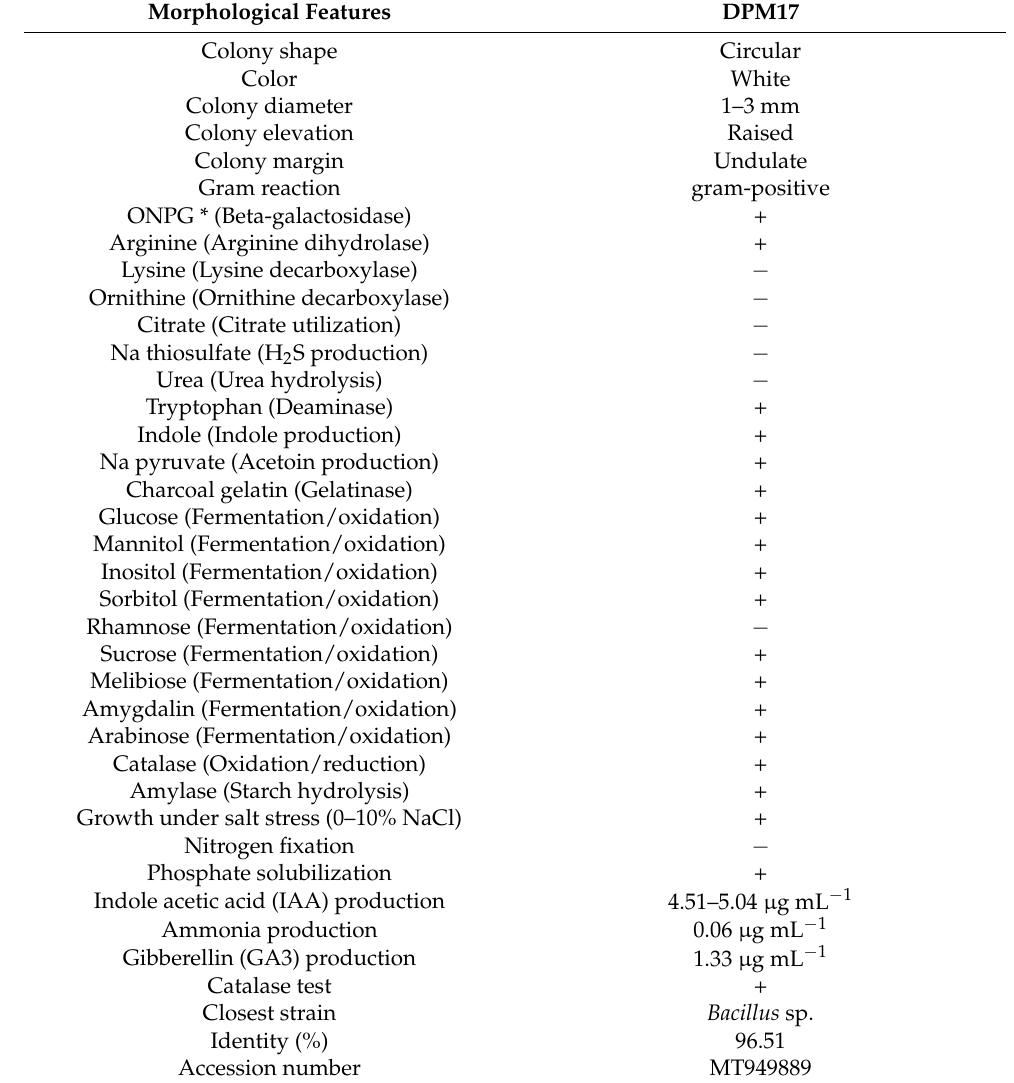
Table 1. Polyphasic DPM17